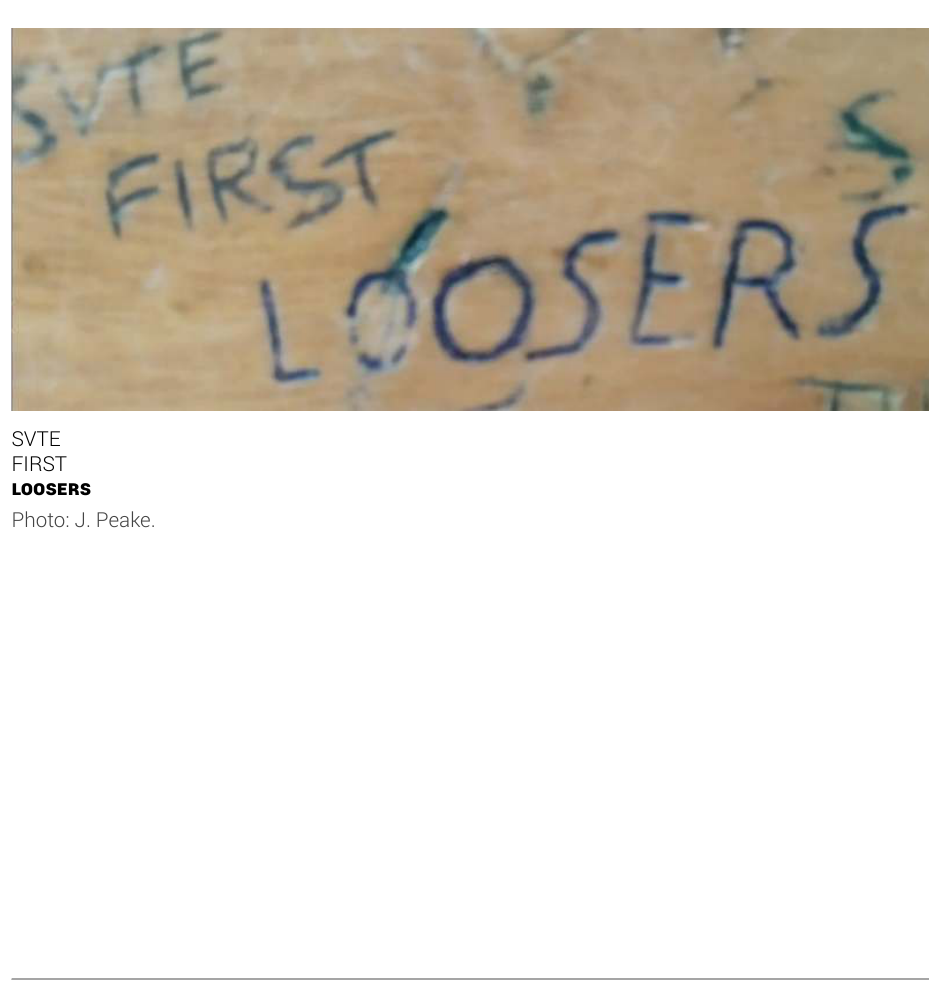
Table 3 c: Gaming reference found on desktops at the University of Bordeaux